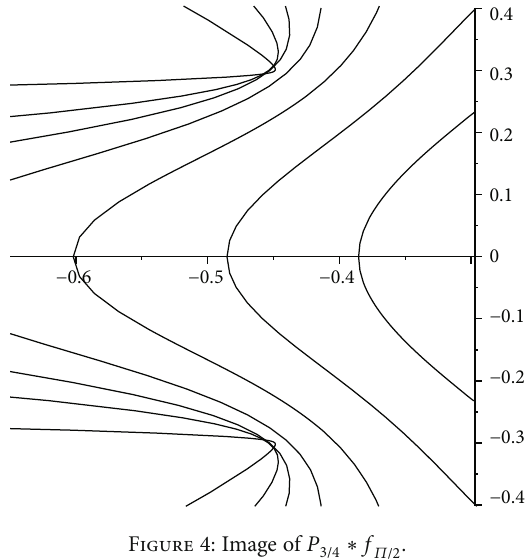
Figure 4: Image of P